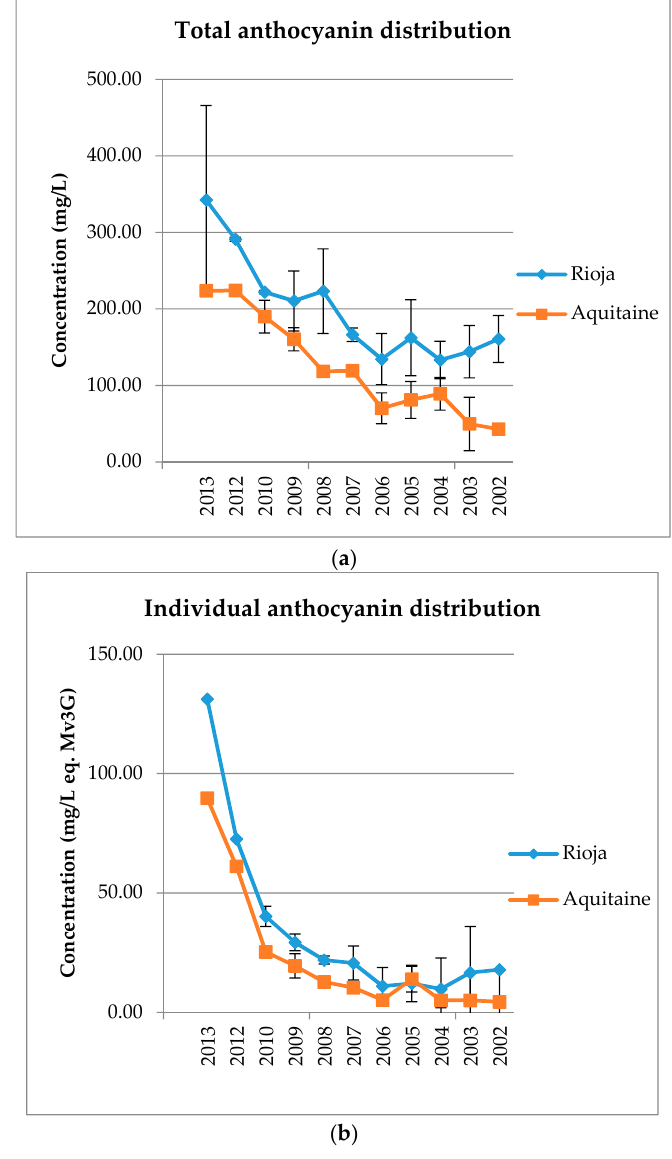
Figure A1. Total ( a ) and individual ( b ) anthocyanin distribution for Rioja and Aquitaine wines. Error bars are standard deviation of wine samples within each category.